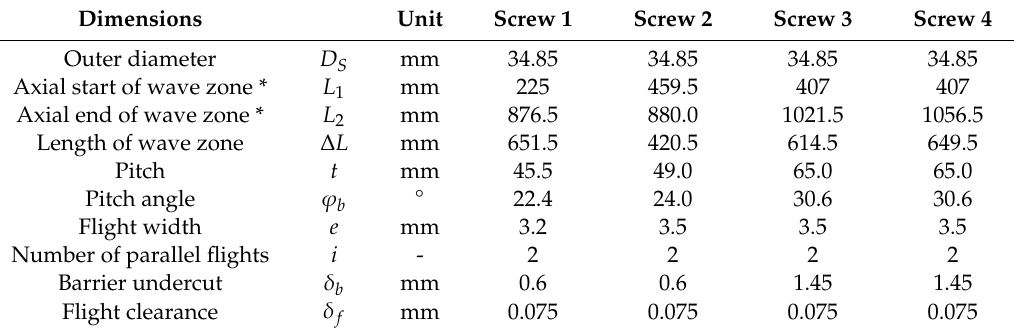
Table 4. Comparison of double-wave zones.